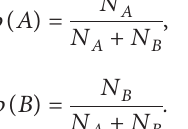
Figure 12: Calibrated BPR function for the interfaceable